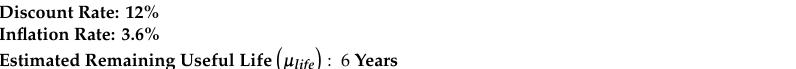
Table A12. PT maintenance cost breakdown for estimated remaining useful